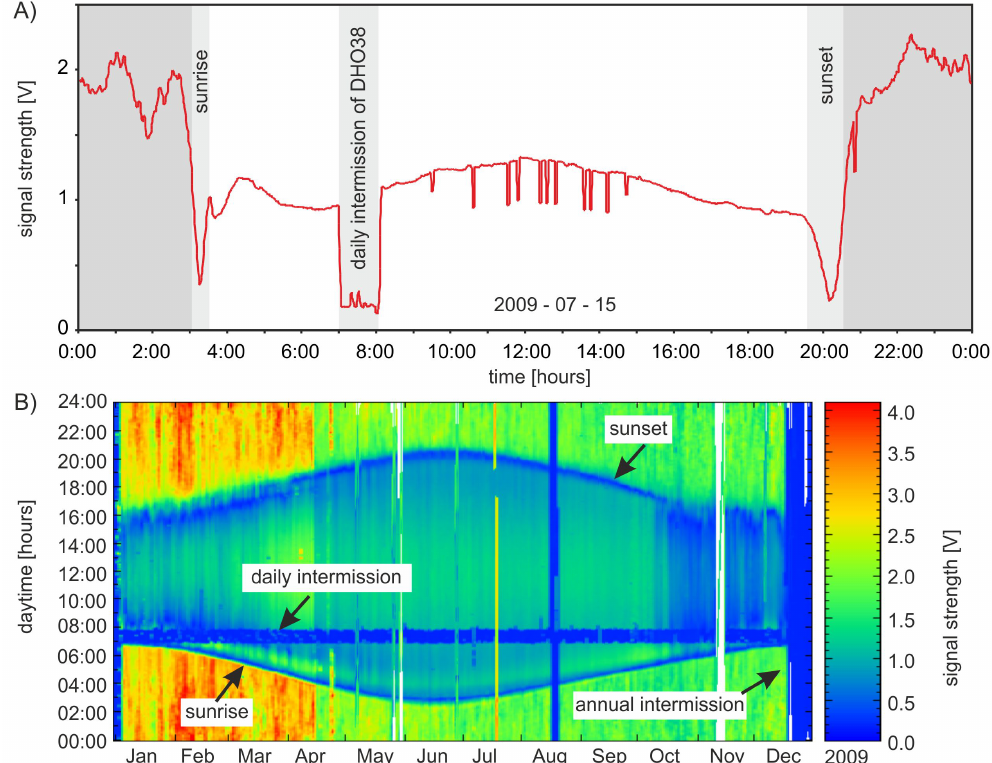
Fig. 6. Signal-strength variation of DHO38, modified after SID Monitoring Station: http://sidstation.loudet.org/home-en.xhtml. (A) Daily broadcasting pattern as received near Toulouse on 15 July 2009. Between sunrise and sunset the received signal strength is nearly constant. During night, sunrise, and sunset the received signal strength varies over a wide range. Between 07:00 and 08:00UTC a regular daily intermission in the broadcasting of DHO38 is abided. This daily intermission occurs throughout the year. (B) Annual broadcasting pattern. A seasonal influence is related to the solar altitude. An intermission in the broadcasting during several days is scheduled during the turn of every